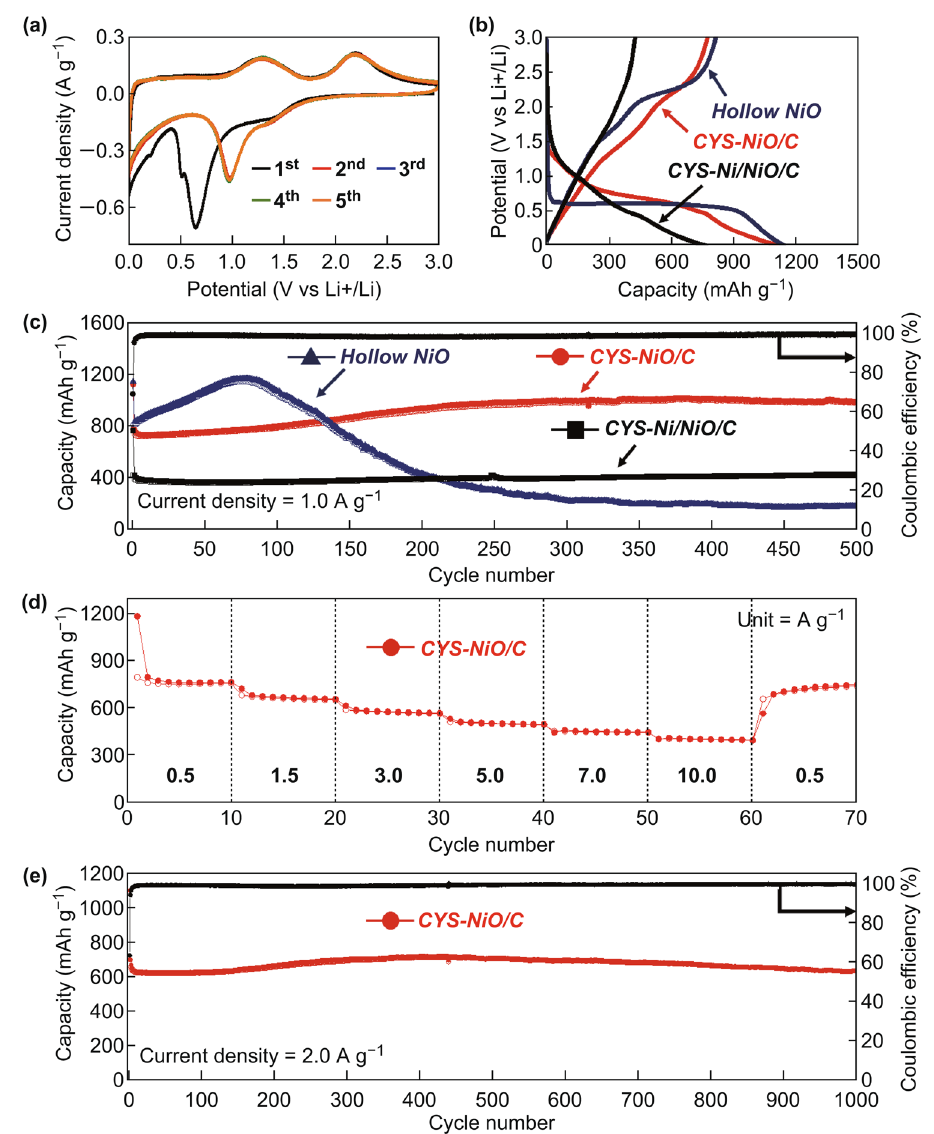
Fig. 7 Electrochemical properties of the CYS‑NiO/C, CYS‑Ni/NiO/C, and hollow NiO microspheres for lithium‑ion storage: a CV curves of the CYS‑NiO/C microspheres, b 1st charge/discharge curves at the current density of 1.0 A g −1 , c cycling performance at the current density of 1.0 A g −1 , d rate performance of the CYS‑NiO/C microspheres, and e long‑term cycling performance of the CYS‑NiO/C microspheres at the current density of 2.0 A g